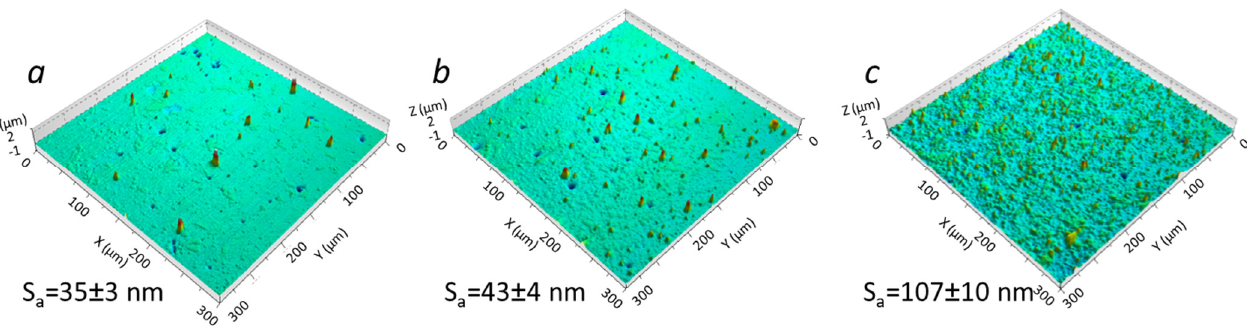
Figure 4. Three-dimensional profile images of TiN coatings deposited onto D2 tool steel substrate in BAI ( a ), CC7 ( b ) and AIP ( c ) deposition systems. The surface roughness values S a are also added [26]. The nodular defects are the sharp peaks, while the blue dots are craters. The scan area was 300 µm × 300 µm, while the z-scale was 3 µm.